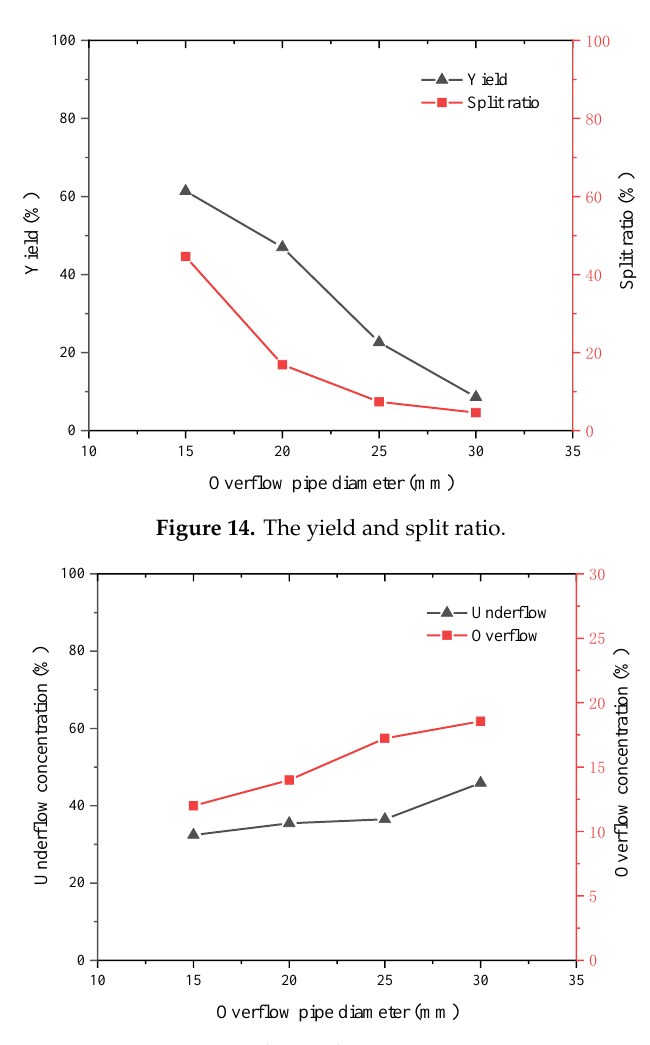
Figure 15. The product concentration.